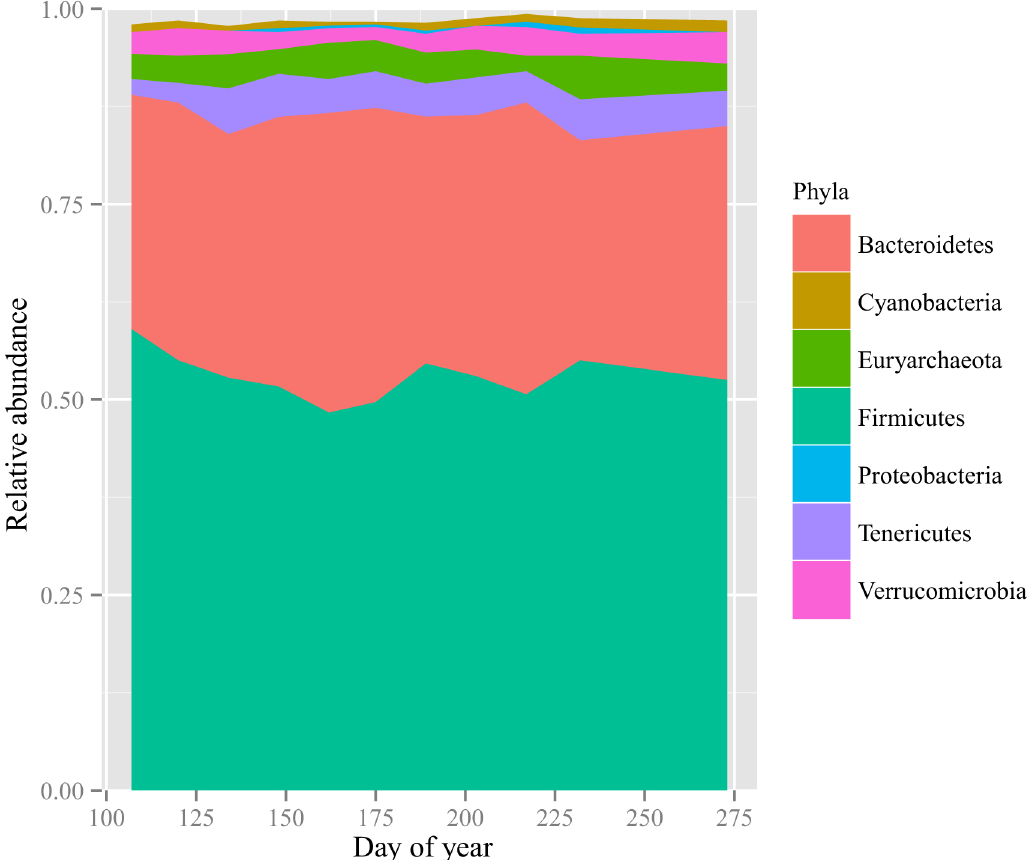
Fig 3. Relative abundance of microbial phyla as indicated by sequencing of 16S ribosomal RNA genes. The effect of time on each microbial phylum was tested using repeated measures ANOVA with Bonferroni correction. The phylum Tenericutes exhibited a significant shift in relative abundance over the growing season ( P <